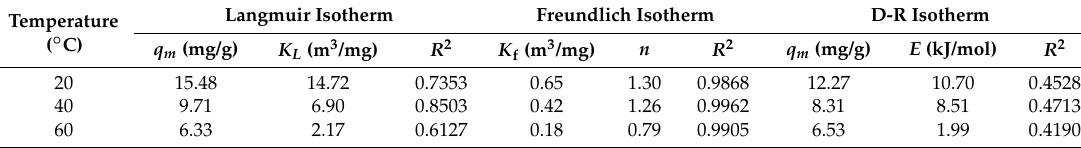
Table 3. Equilibrium HCHO adsorption amount per unit BET area of the adsorbents.